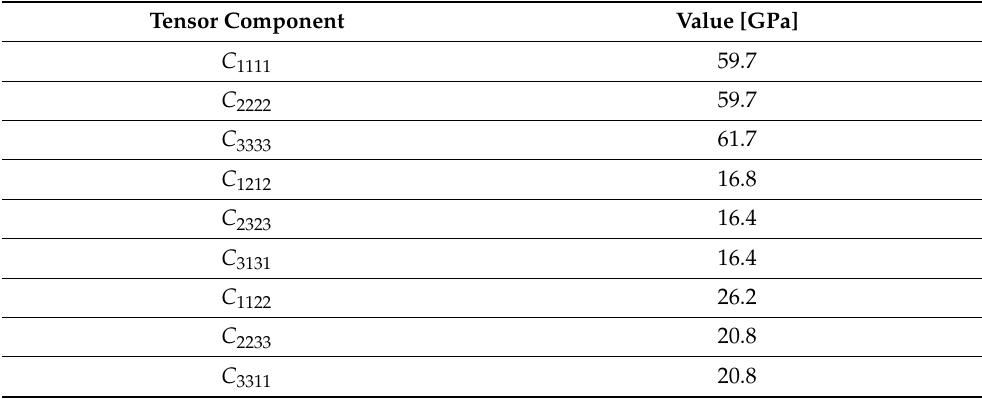
Table 1. Elastic constants of Magnesium.